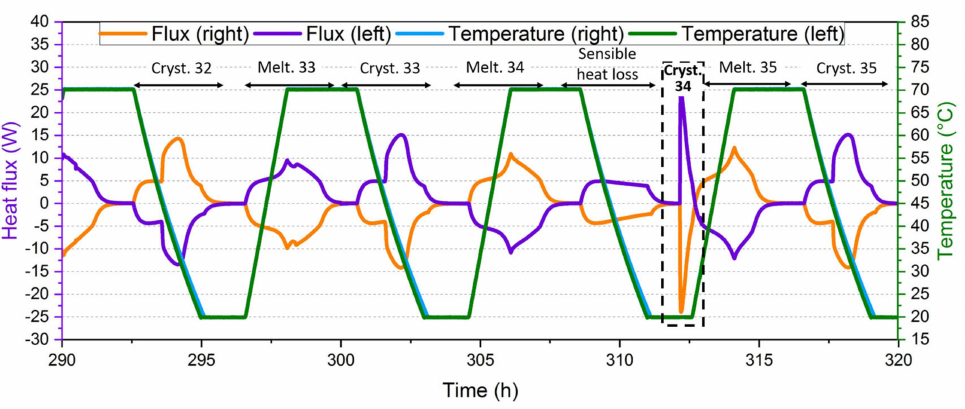
Figure 14. Ramps of temperature and heat fluxes measurements during thermal cycling of sodium acetate trihydrate